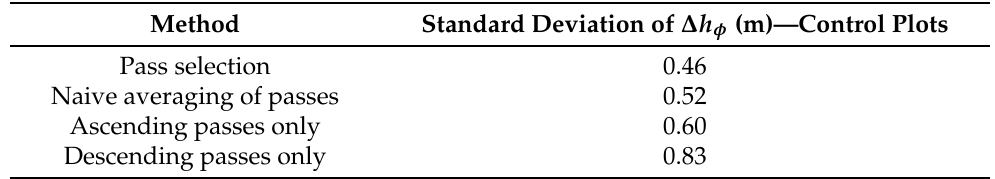
Table 3. Stability of ∆ h φ in eleven control plots where no logging took place, by the four methods described in Section